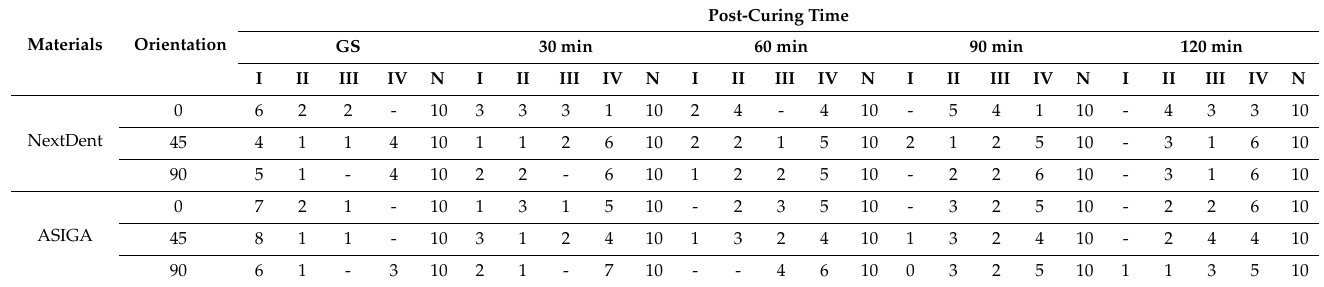
Table 4. Mode of specimens fractures according to shape and position of fracture